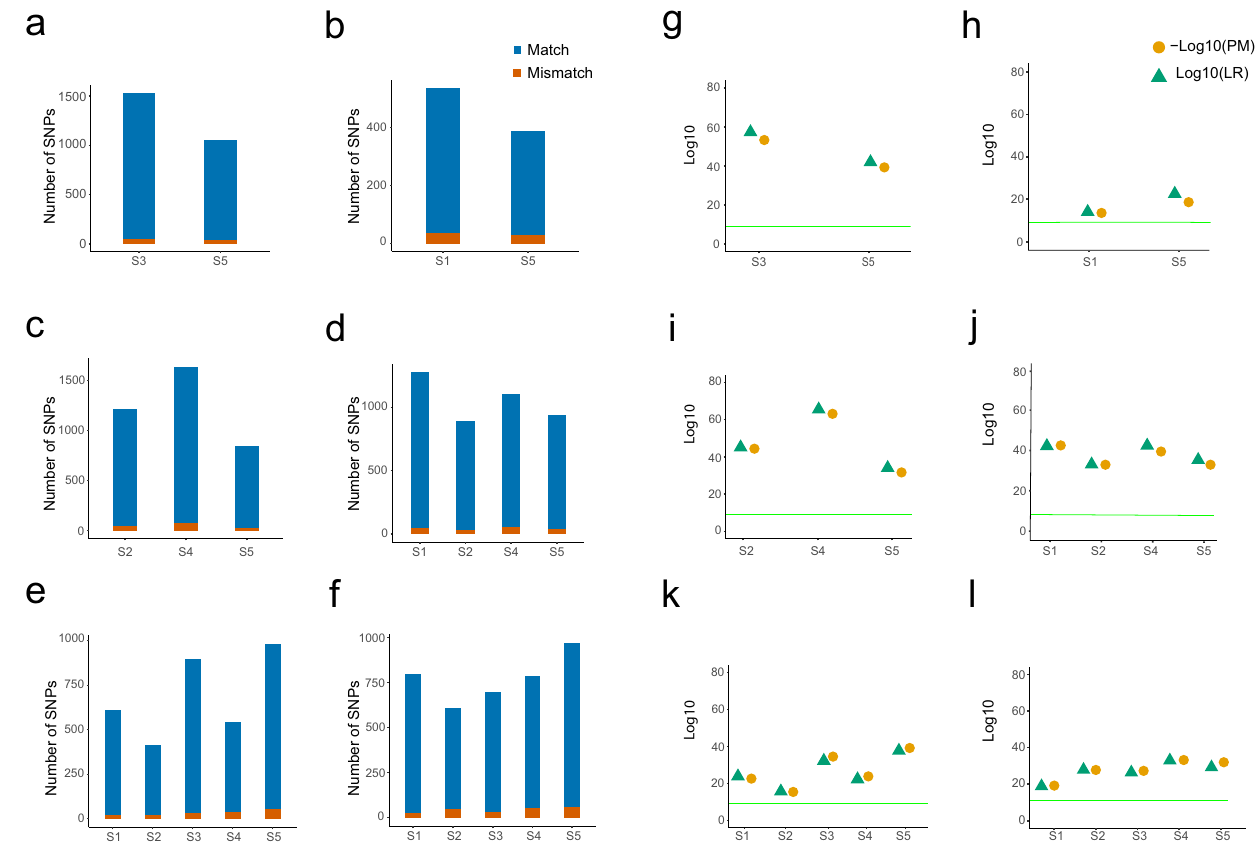
Fig. 4 Individual genetic identi fi cation of separated mixture contributors via de-goulash analysis of single-cell transcriptome sequencing data obtained from balanced mixtures involving 2 – 9 individuals. Number of matching identity SNPs towards the whole-exome sequencing reference ( a – f ). a Blood mixture of two individuals (dataset M2), b blood mixture of two individuals with closely related mtDNA haplogroups (dataset M2-cl), c blood mixture of three individuals (dataset M3), d blood mixture of four individuals (dataset M4), e in silico data mixture of fi ve individuals (dataset M5), f in silico data mixture of nine individuals of which only fi ve individuals had WES reference data available for individual genetic identi fi cation (dataset M9). Statistical-based individual genetic identi fi cation. as logarithmic expression of LR and PM ( g – l ). Likelihood ratio (LR) and probability matching (PM) were used as statistical parameters to determine the strength of the evidence of a genetic match for individual genetic identi fi cation. Green line represents the 10E9 LR threshold for correct identi fi cation. g Blood mixture of two individuals (dataset M2), h blood mixture of two individuals with closely related mtDNA haplogroups (dataset M2-cl), i blood mixture of three individuals (dataset M3), j blood mixture of four individuals (dataset M4), k in silico data mixture of fi ve individuals (dataset M5), l in silico data mixture of nine individuals of which only fi ve individuals had WES reference data available for individual genetic identi fi cation (dataset